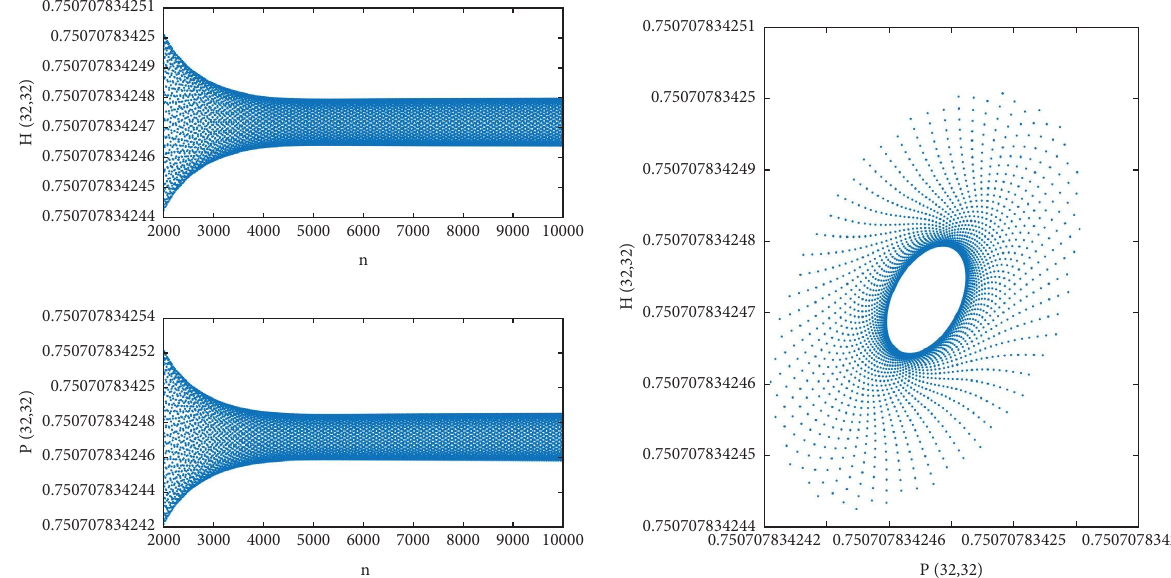
,d ) � ( 0 . 2 , 0 . 179452 ) falls at the junction of regions I and II in Figure 9(a), 1 2